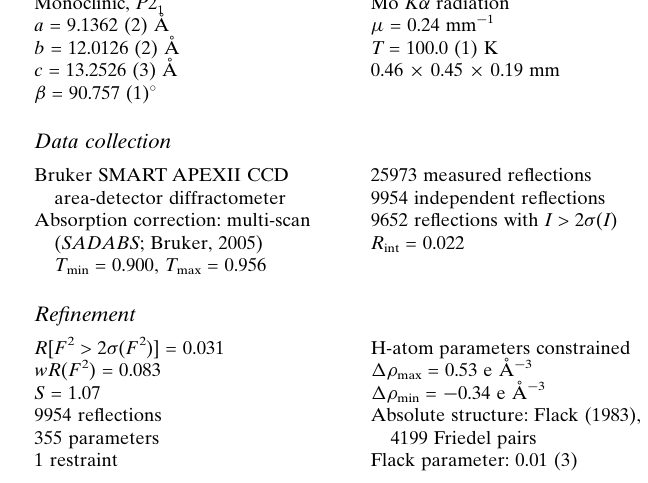
Key indicators: single-crystal X-ray study; T = 100 K; mean (cid:1) (C–C) = 0.002 A˚; disorder in main residue; R factor = 0.031; wR factor = 0.083; data-to-parameter ratio = 28.0. crystallographically independent ion pairs ( A and B ) in the asymmetric unit with slightly different conformations due to the disordered methyl groups in the anion of molecule A . Two motifs. In molecule A , the methyl groups are disordered over two sets of positions with a site-ocuppancy ratio of